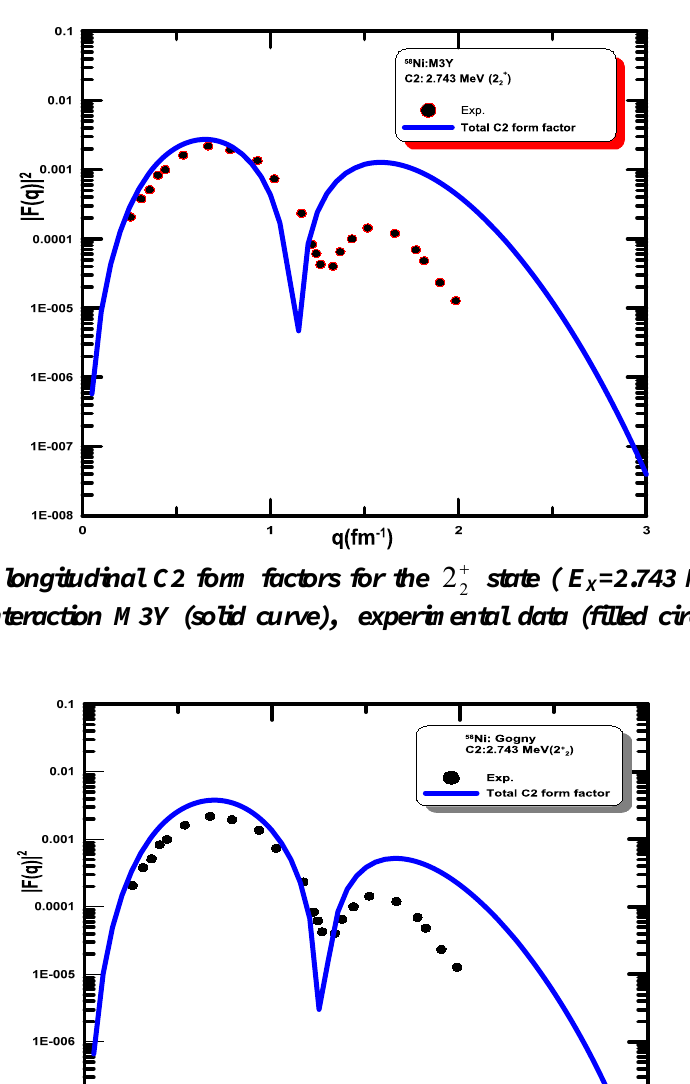
Fig. 4: Inelastic longitudinal C2 form factors for the state (2.743 MeV) in with a residual interaction Gogny (solid curve), experimental data (filled circle) are taken from Ref.